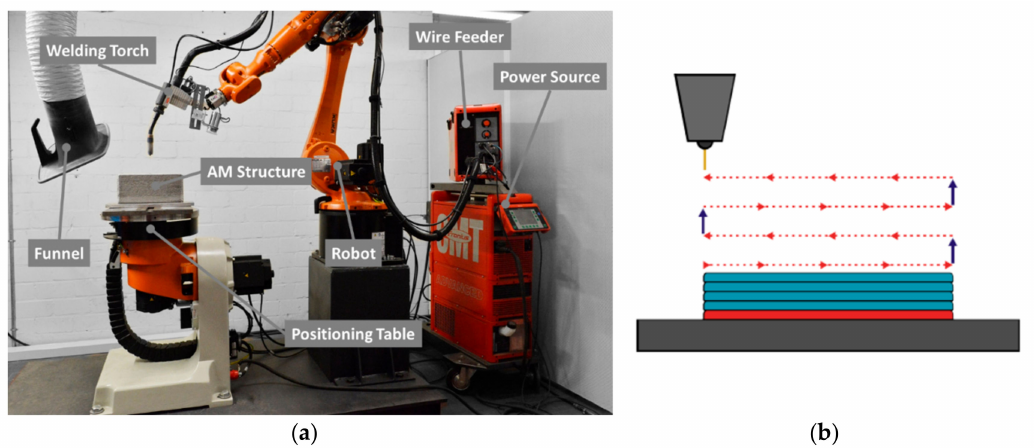
Figure 1. Experimental setup for robot-guided wire and arc additive manufacturing (WAAM) ( a ) and a schematic process sequence for sample manufacturing ( b ).